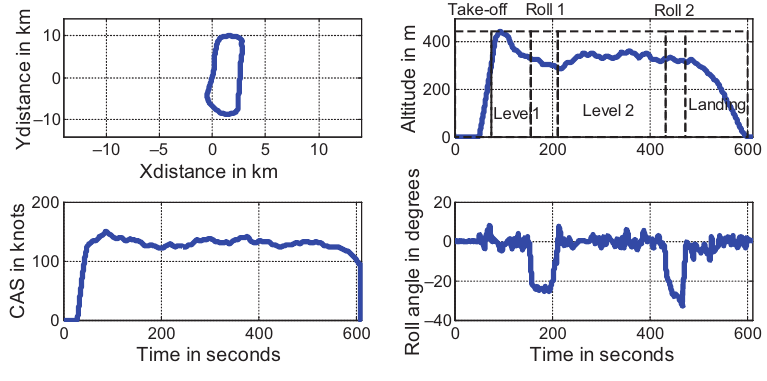
Figure 3. Flight